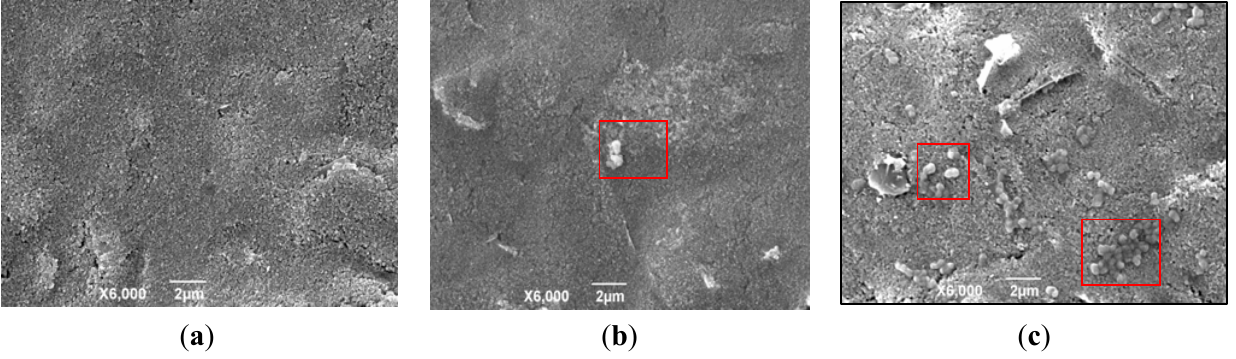
Figure 2. SEM images of the GNP-SPCE surface. ( a ) Clean surface; ( b ) Bacteria bound to surface from sample of 4 × 10 3 CFU/mL; ( c ) Bacteria bound to surface from sample of 4 × 10 7